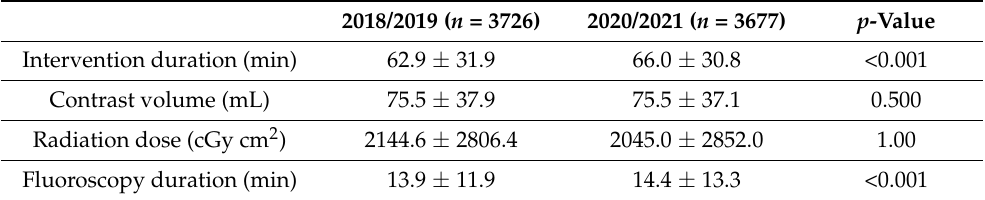
Table 4. Intervention details (2018/2019 vs. 2020/2021).